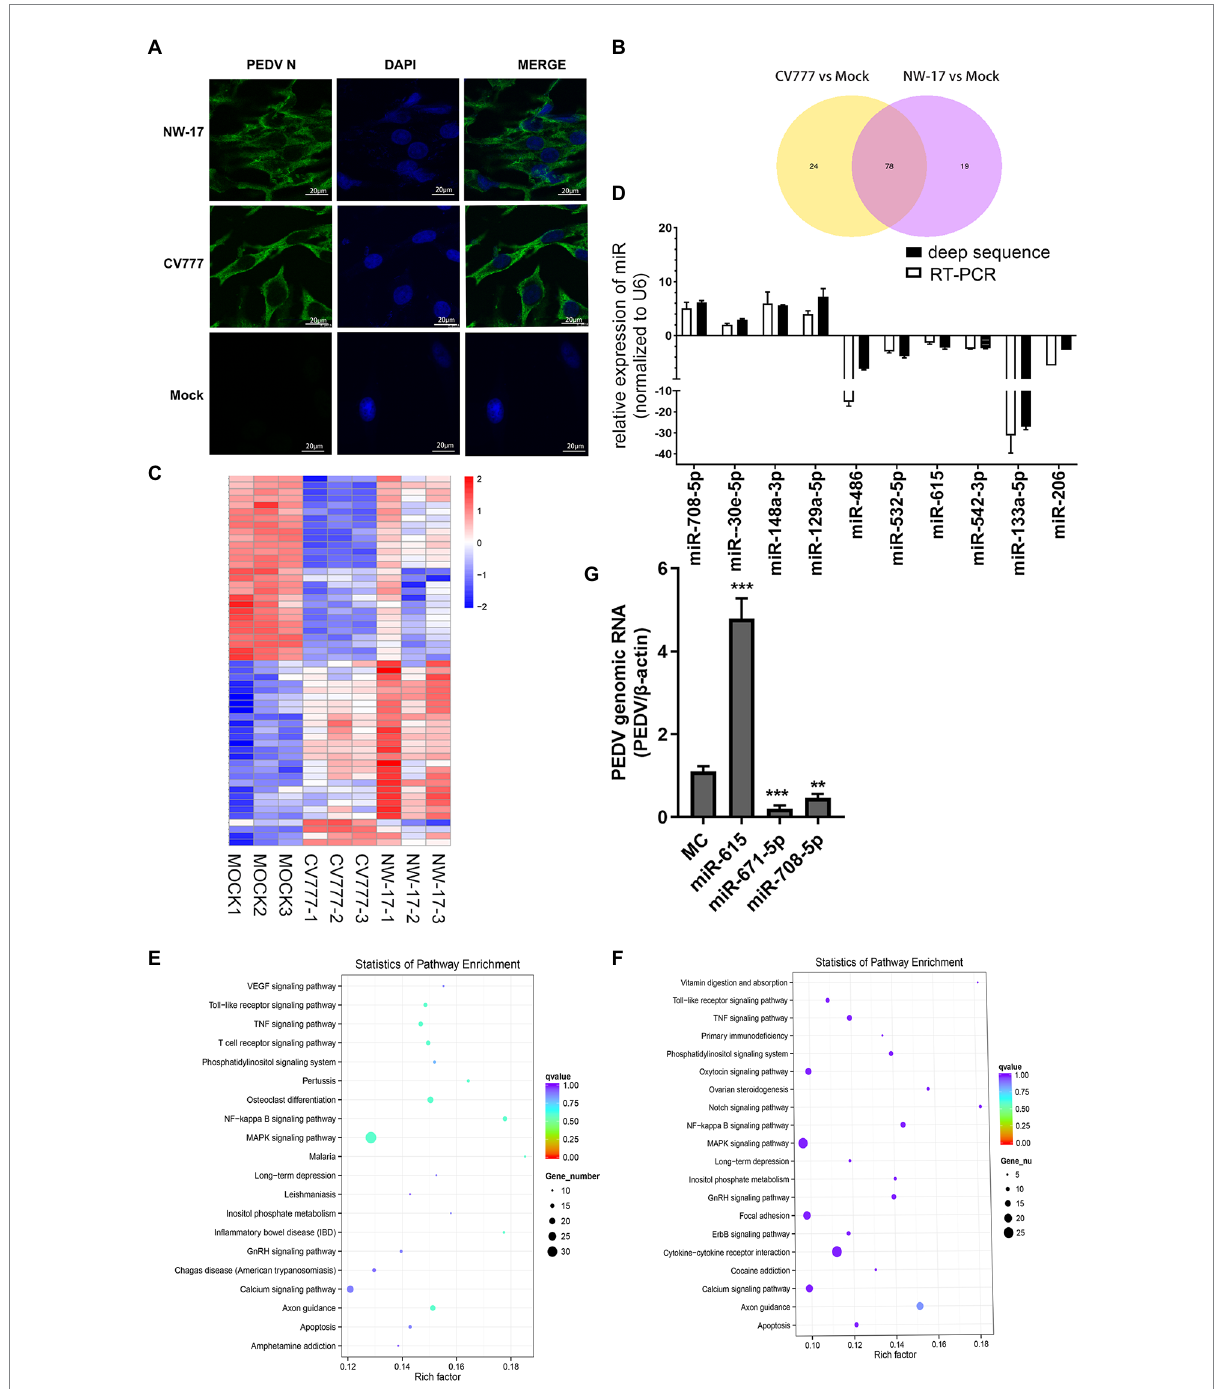
FIGURE 1 PEDV infection changes cellular microRNA profiles. (A) Immunofluorescence showing PEDV N protein expression in IECs (green). IECs were infected with the CV777 and NW-17 strains at a multiplicity of infection (MOI) of 1. Cells were fixed and stained with a mouse anti-N monoclonal antibody (mAb). Scale bar = 20 μ m. (B) Venn diagrams showing the differentially expressed microRNAs (DEMiRs) among CV777-infected vs. mock- infected cells and NW-17-infected vs. mock-infected cells. (C) Heatmap showing the high abundance of DEMiRs. (D) Verification of the miRNA microarray assay using RT-qPCR. Data from RT-qPCR are shown as the mean ± SD of three independent experiments. U6 mRNA was detected as a control. (E and F) KEGG pathway enrichment analysis of the main DEMiRs for the CV777- and NW-17-infected groups, respectively. (G) Transfection of miRNAs inhibited or enhanced viral replication. IECs were transfected with the miR-671-5p, miR-708-5p, miR-615, or MC mimics at 50 nmol, followed by infection with PEDV (MOI = 1). Cells were collected for RT-qPCR at 24 h post-infection (hpi). PEDV genomic RNA was determined by RT-qPCR. Asterisks indicate statistical significance. * p < 0.05; ** p < 0.01; *** p <